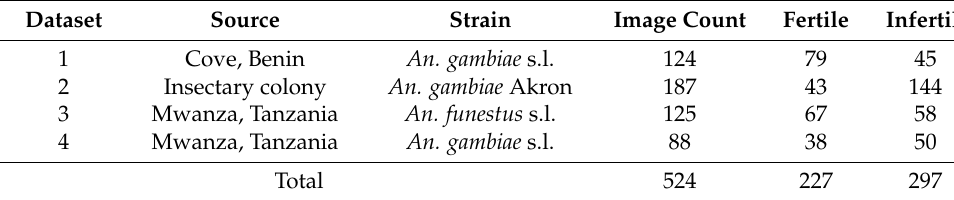
Table 1. Image dataset